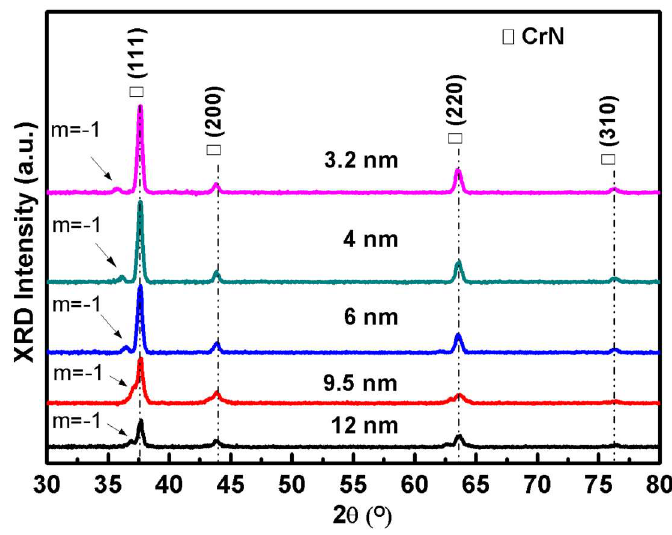
Figure 3. X-ray di ff ractometer (XRD) patterns obtained from CrN / CrAlSiN multilayer coatings with Figure 3. X-ray diffractometer (XRD) patterns obtained from CrN/CrAlSiN multilayer coatings with bi-layers of various thicknesses: 12, 9.5, 6, 4, and 3.2 nm. bi-layers of various thicknesses: 12, 9.5, 6, 4, and 3.2 nm.